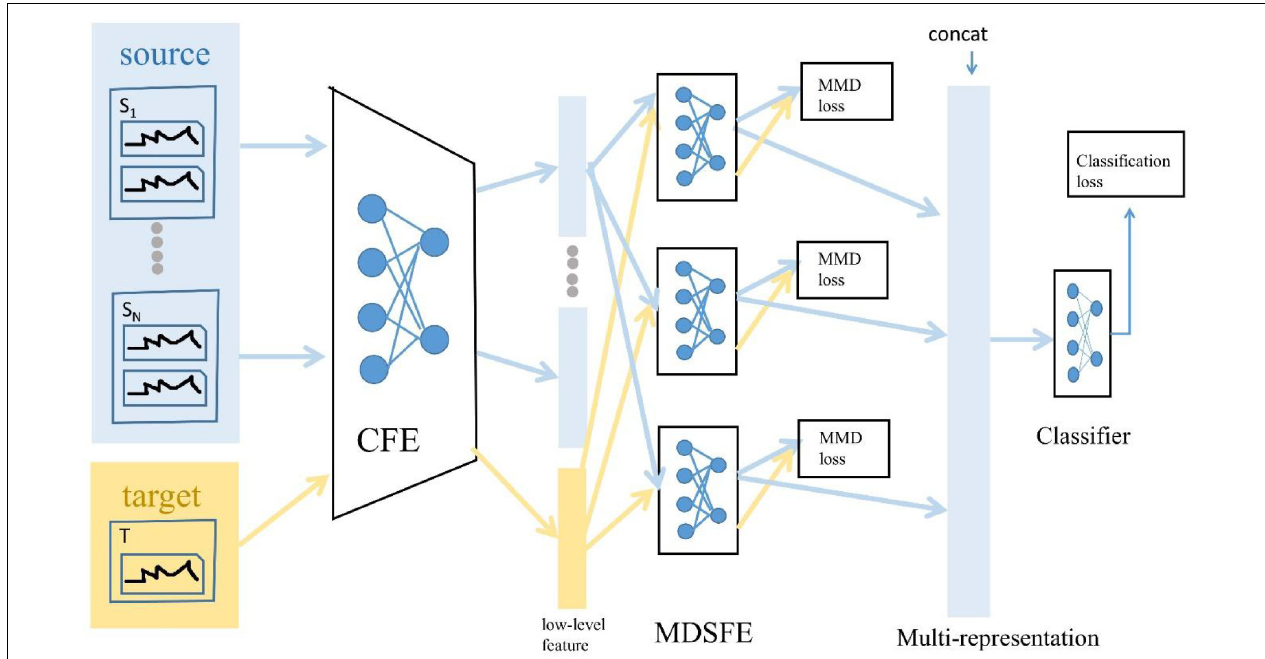
FIGURE 3 | Architecture of proposed Multi-Source and Multi-Representation Adaptation (MSMRA)